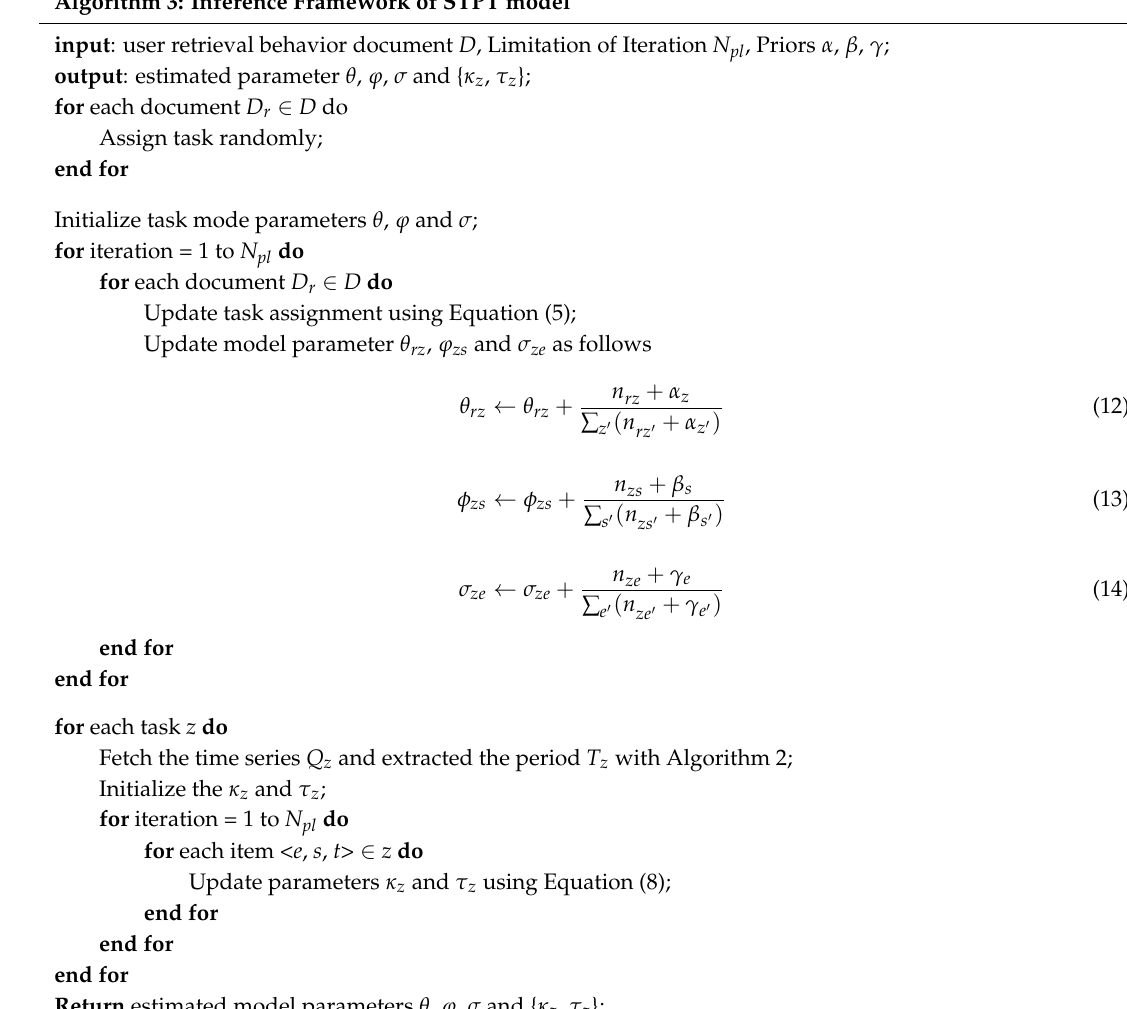
Algorithm 3: Inference Framework of STPT